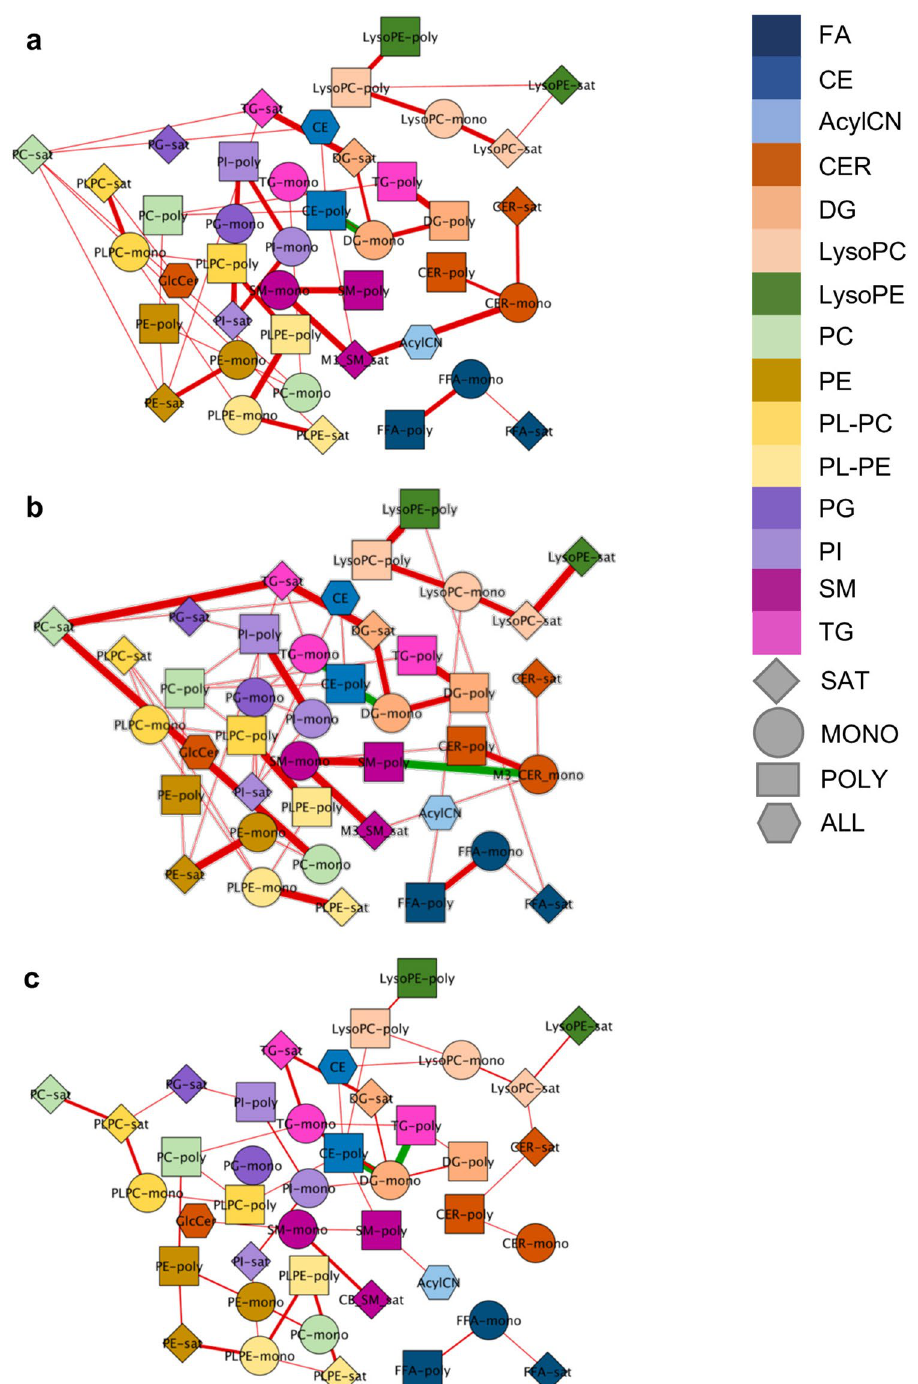
Figure 3. Correlation between lipid groups differs between maternal and cord blood samples. The relationship between lipid groups was estimated using debiased sparse partial correlations within ( a ) M1 (45 edges), ( b ) M3 (55 edges), and ( c ) CB (47 edges). Colors of nodes depict class of lipid. Shapes of nodes depict number of double bonds. Positive correlations are depicted using red edges. Inverse correlations are depicted using green edges. Weight of the edges signifies a more significant correlation. Edges represented have an adjusted p-value <